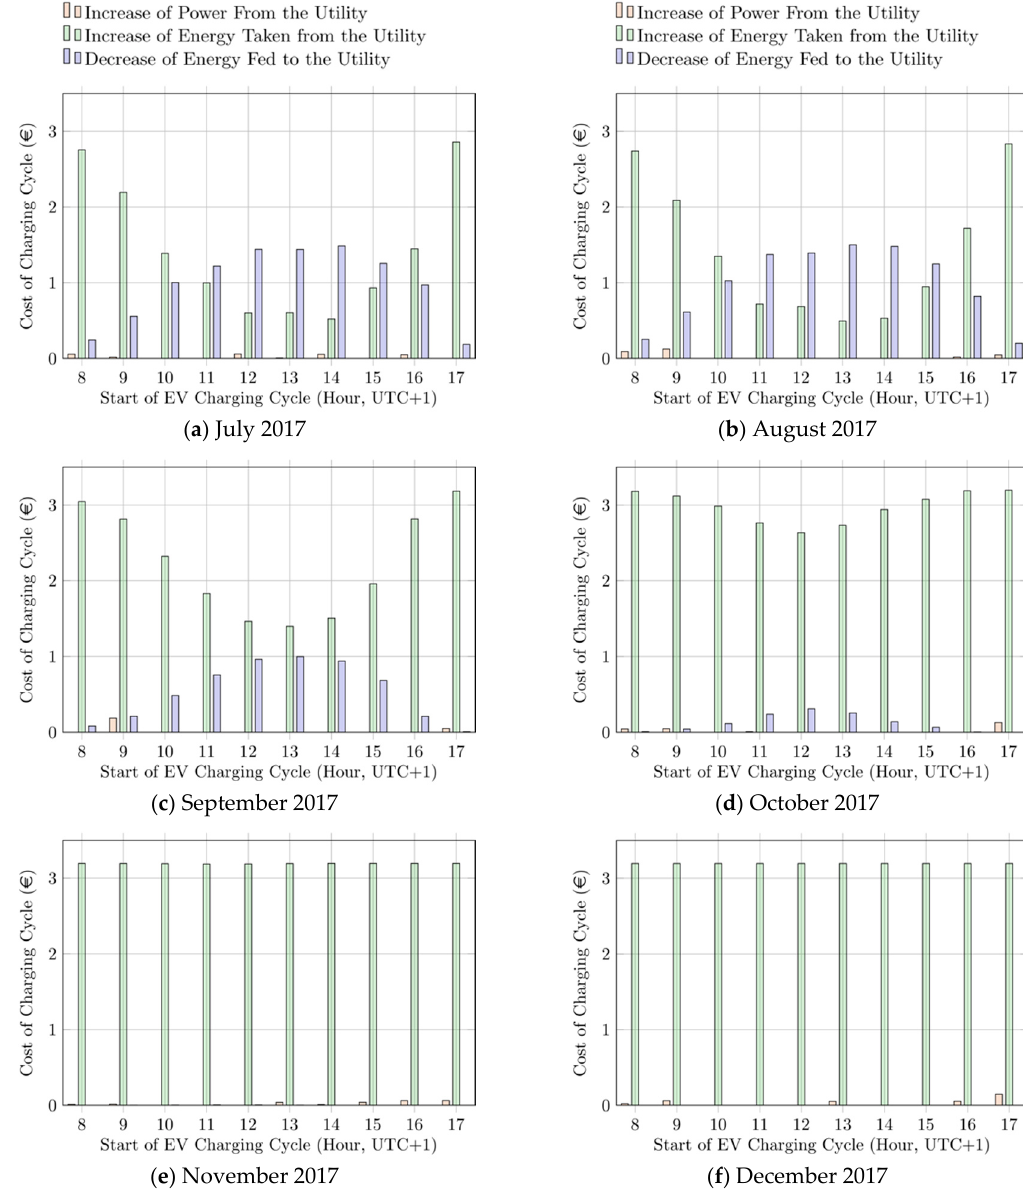
Figure 11. Electric vehicle (EV) charging cost components (€) from July to December 2017, as depicted from sub-figure ( a ) to sub-figure ( f ), respectively. The cost components are presented for each charging cycle, depending on the time of arrival of the EV at the charging station. UTC: Universal Time Coordinated.